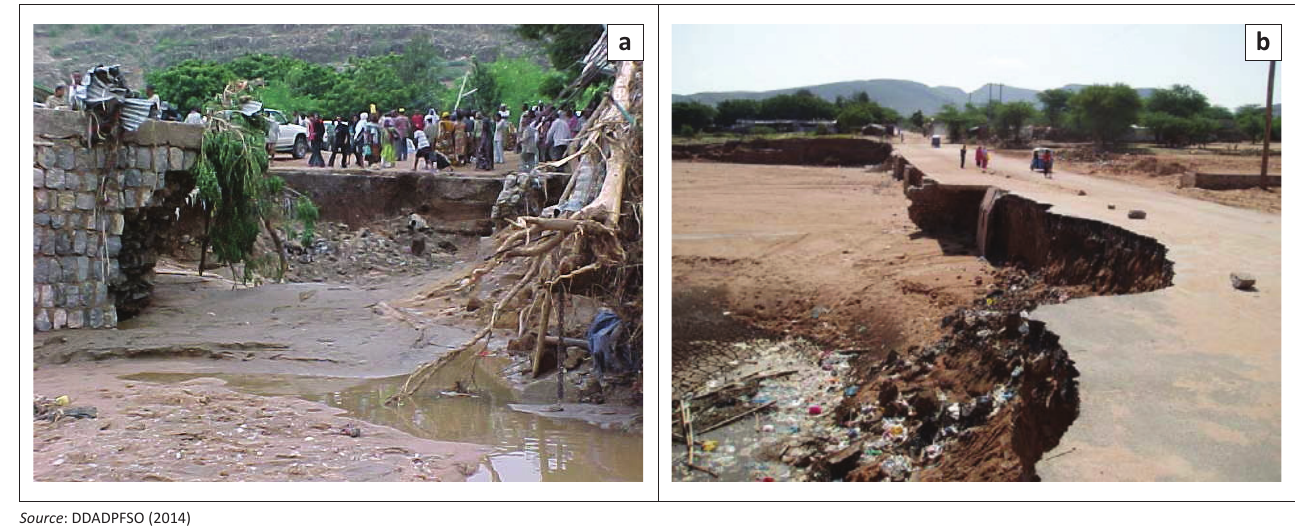
FIGURE 3: (a & b) Damage caused by 2006 floods on Dachatu Bridge and the road.